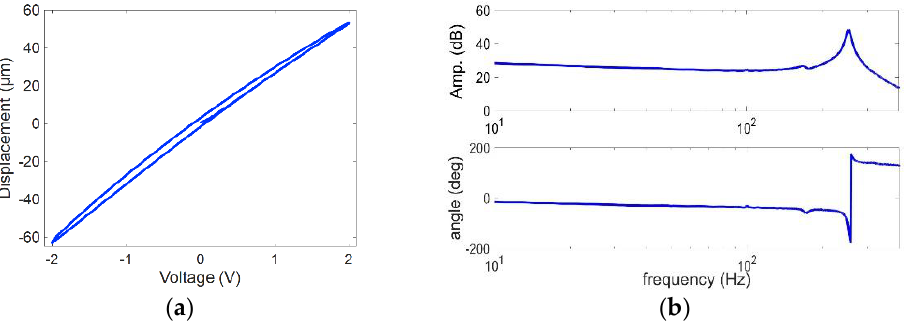
Figure 9. Response of experimental testing of the FTS system, ( a ) the output motion related to the applied voltage and ( b ) the frequency response function.